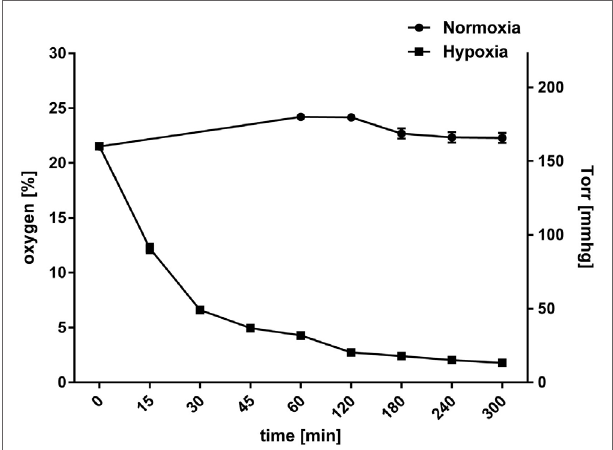
FiGUre 1 | oxygen levels in neutrophil suspension cultures . Neutrophils were incubated under normoxia (21%) or hypoxia (1%). Dissolved oxygen levels in neutrophil suspension culture were monitored for 5 h. Plotted values represent mean ± SEM and are displayed as % oxygen on the left y -axis and mmHg oxygen on the right y -axis. Starting at 21.5 ± 0.14% (normoxia) and 21.5 ± 0.21% (hypoxia) after 5 h, the oxygen level dropped to 1.79 ± 0.03% under hypoxia, while it stayed relatively constant around 22.3 ± 0.46% under